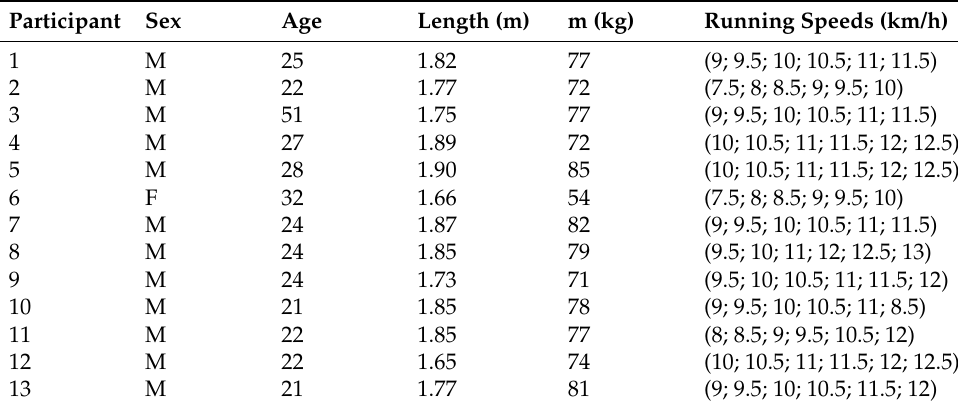
Table 2. Participant information (Male (M), Female (F)).